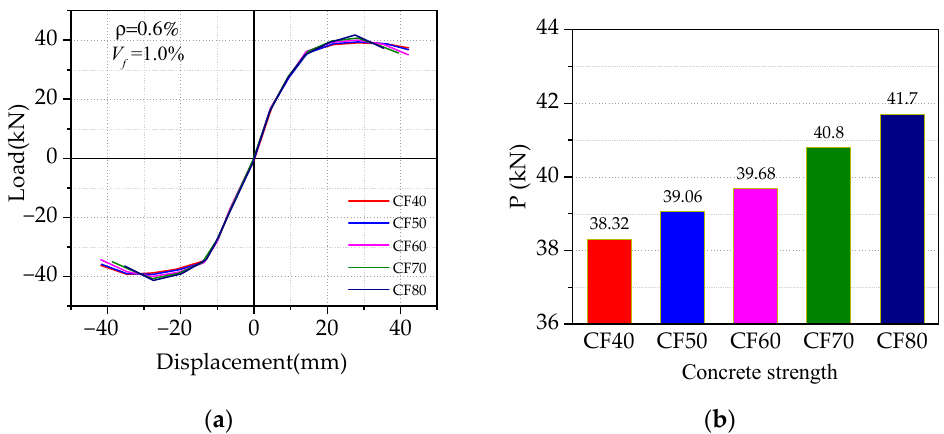
Figure 11. Effect of concrete strengths: ( a ) comparison of skeleton curve; ( b ) comparison of peak load.